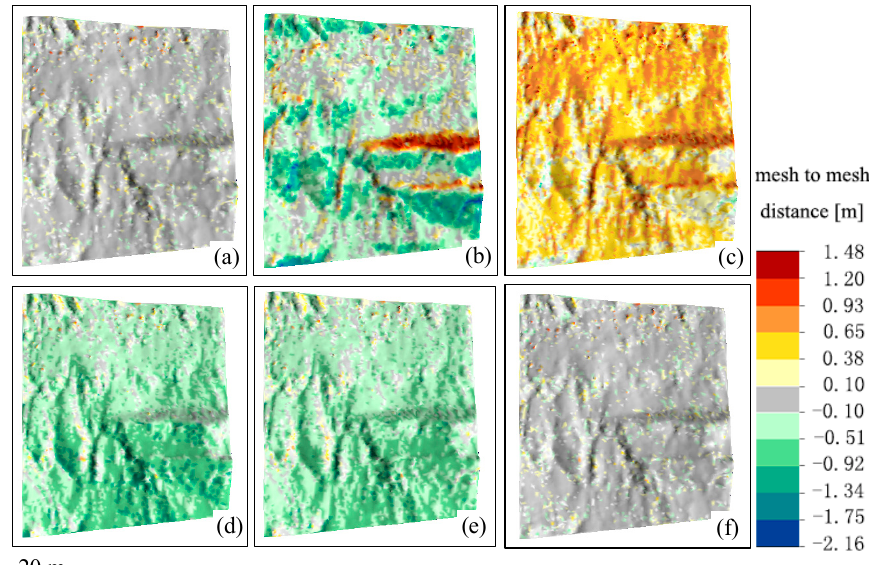
Figure 7. Distance map of the a1 area in site A between the two temporal TLS surveys achieved by ( a ) the manual ‐ based, ( b ) Super4PCS, ( c ) MSSF ‐ Super4PCS, ( d ) Super4PCS+ICP, ( e ) MSSF ‐ Super4PCS+ICP, and ( f ) the proposed method.